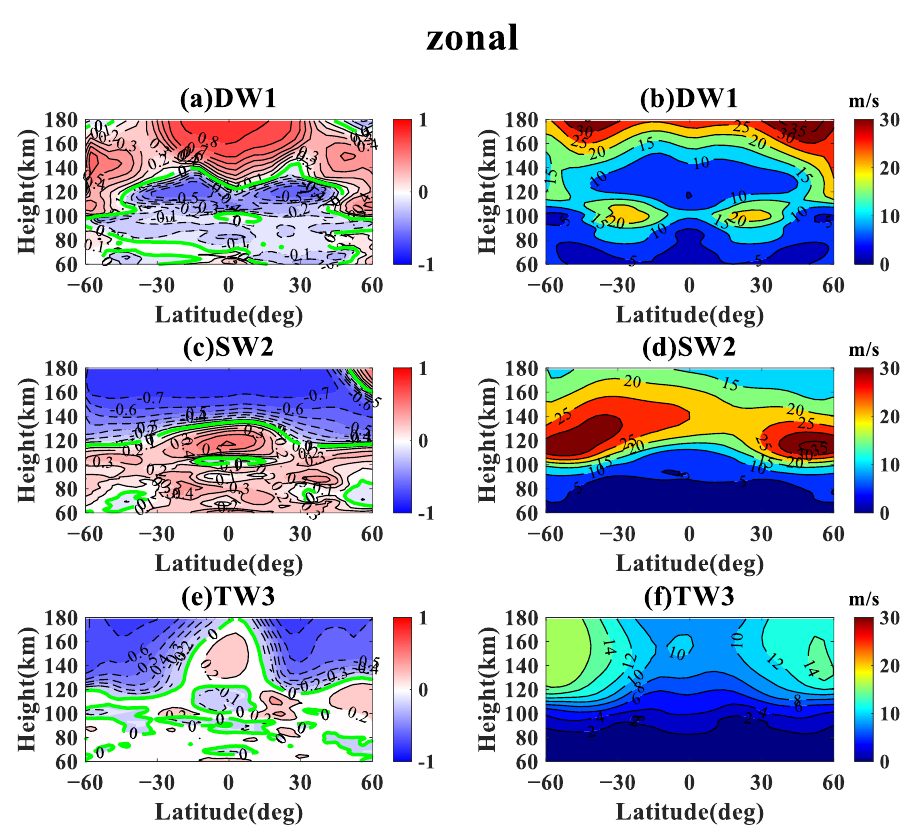
Figure 2. The correlation between migrating tidal variations ( a ) DW1, ( c ) SW2, and ( e ) TW3 and F10.7 cm index between 60 ◦ S and 60 ◦ N from 2003 to 2019. The spatial structure between 60 ◦ S and F10.7 cm index between 60 ° S and 60 ° N from 2003 to 2019. The spatial structure between 60 ° S and 60 ◦ N from 2003 to 2019 for ( b ) DW1, ( d ) SW2, and ( f ) 60 ° N from 2003 to 2019 for ( b ) DW1, ( d ) SW2, and ( f ) TW3.